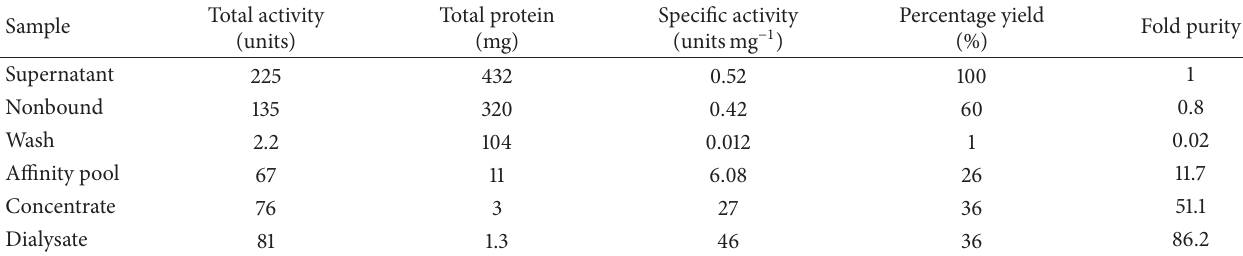
Table 1: Summary of the purification of recombinant Anopheles gambiae glutathione-S-transferase epsilon 2.